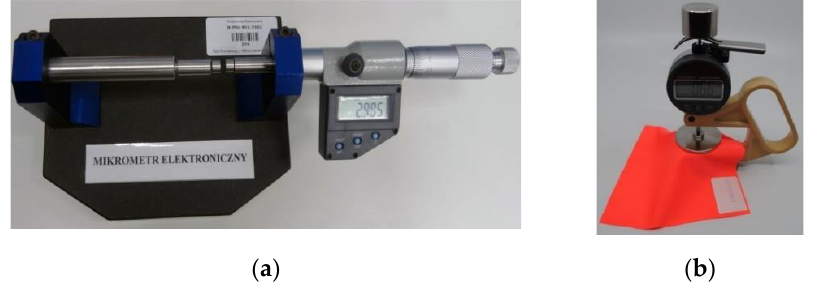
Figure 5. Measurement of substrate thickness: ( a ) preliminary experiment; ( b ) main experiment. Table 3. Results of thickness measurements of substrates in the preliminary experiment.